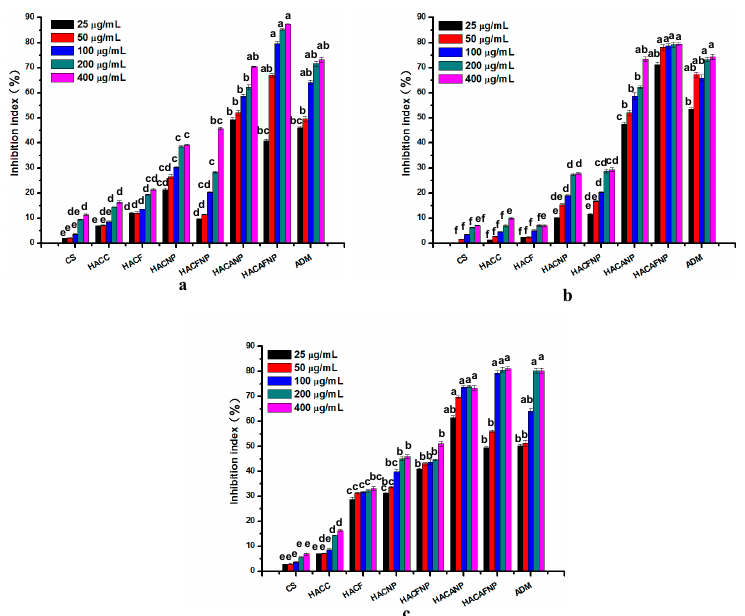
Figure 8. The cytotoxicities of chitosan, chitosan derivatives, and chitosan nanoparticles on MCF-7 ( a ), BGC-823 ( b ), and HEPG-2 cells ( c ). Data are presented as mean value ± SD. Letters that are different in Figure 8, according to various sample concentrations, differ statistically between different samples ( p < 0.05).